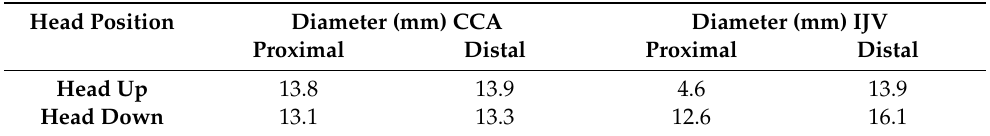
Table 1. Diameter of the proximal and distal common carotid artery (CCA) and the internal jugular vein (IJV) in a head-upright and head-lowered position. Head